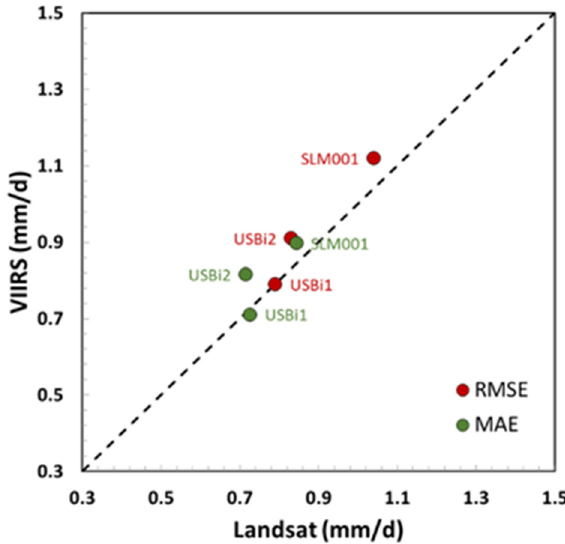
Figure 4. Comparison of RMSE and MAE in retrieved daily Landsat ET and VIIRS ET against observed ET on Landsat overpass days at SLM001, USBi1 and USBi2 sites.